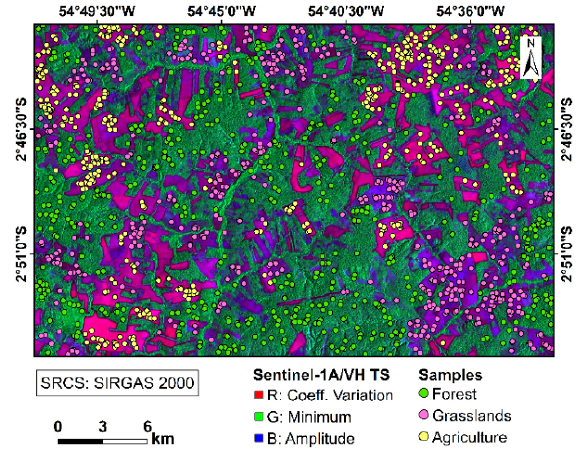
Figure 3. False-colour composite image that uses temporal metrics to emphasize the difference between areas of agriculture, forest and grasslands, along with the invariant